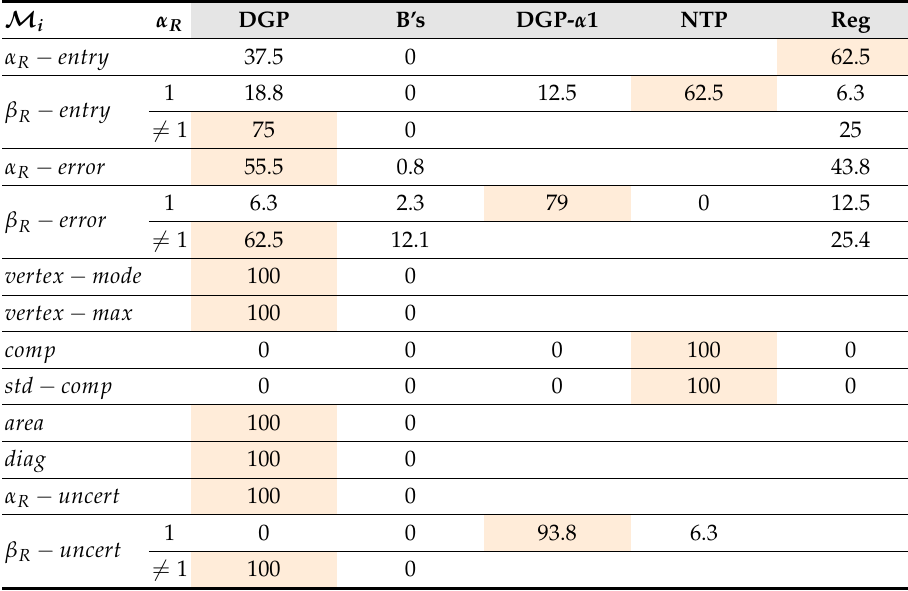
Table 6. Orderings of the algorithms